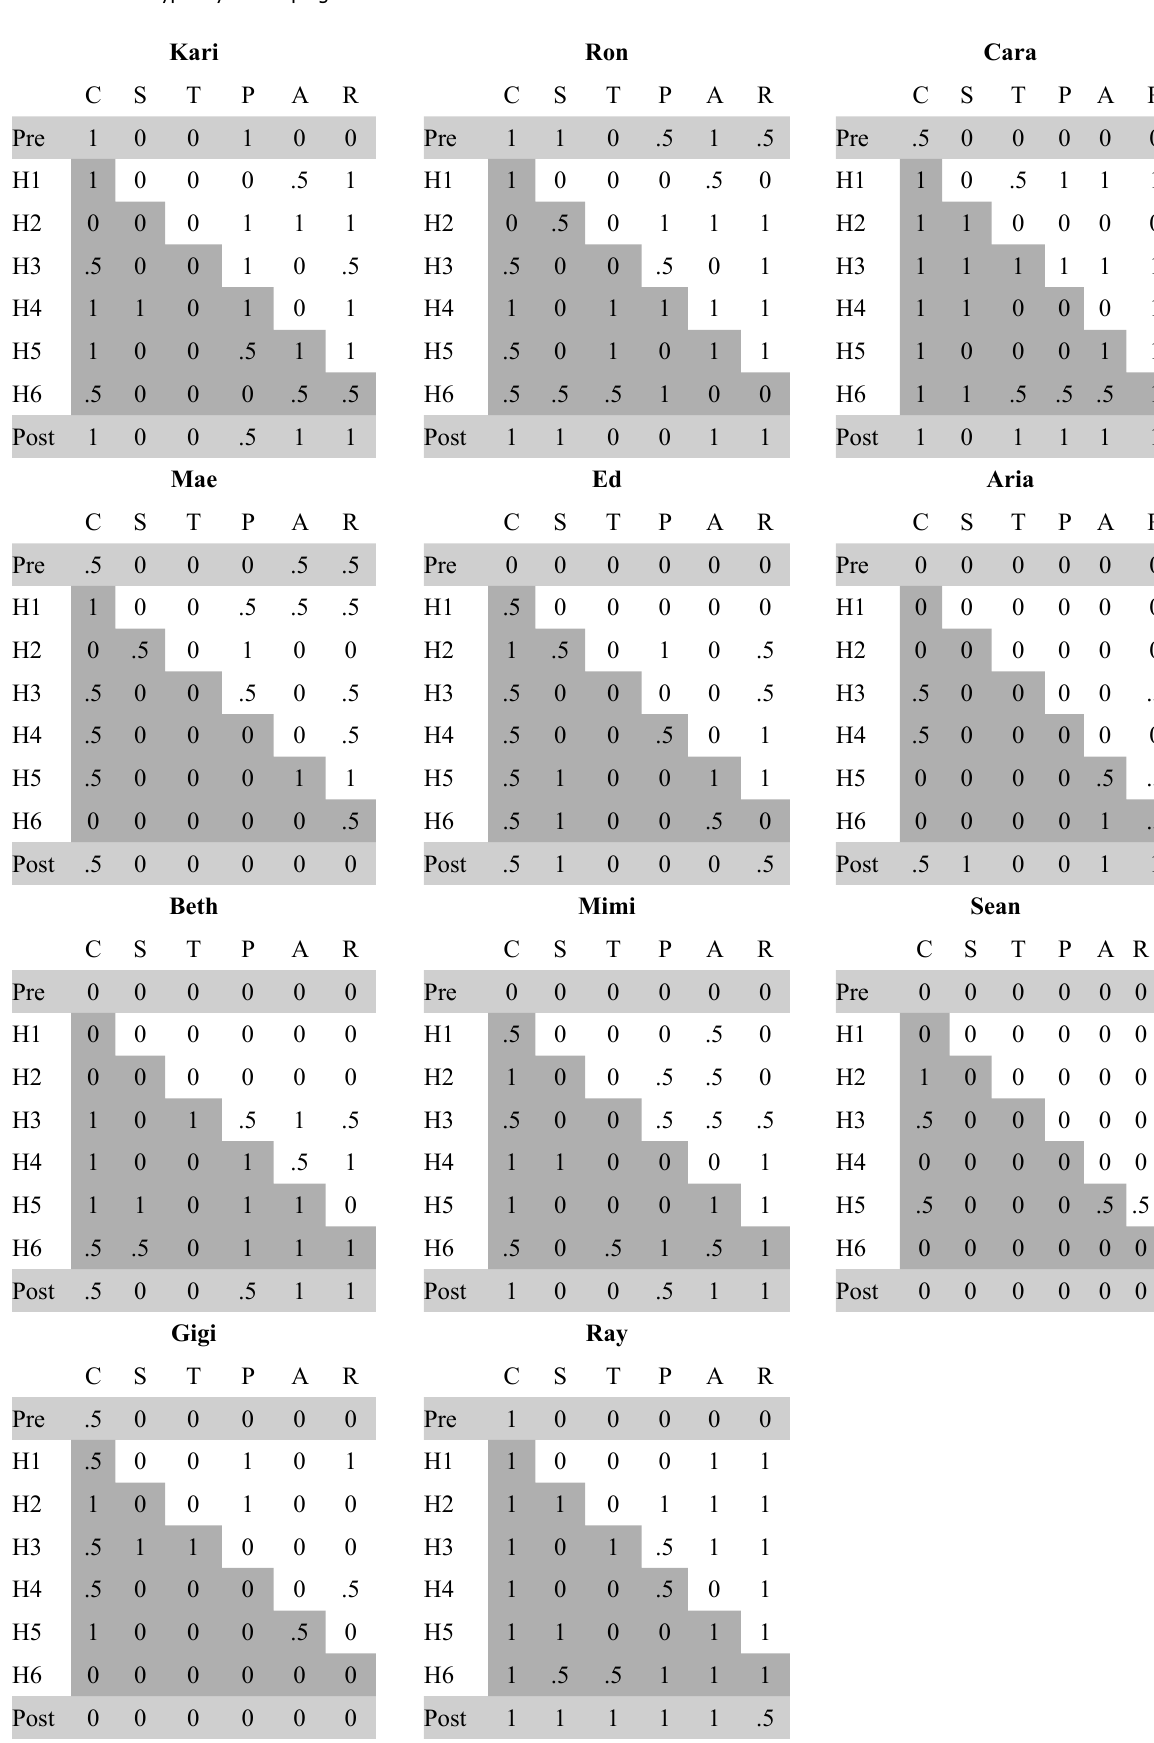
Figure 2 . Insertion of story categories in each story by